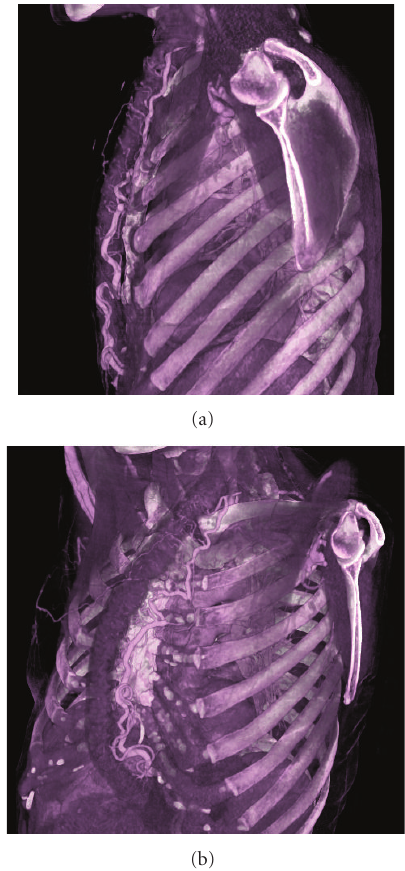
Figure 2: ((a)-(b)) CT images with volume rendering reconstruc- tion show the vascular anastomosis condition without stenosis or low-level perfusion